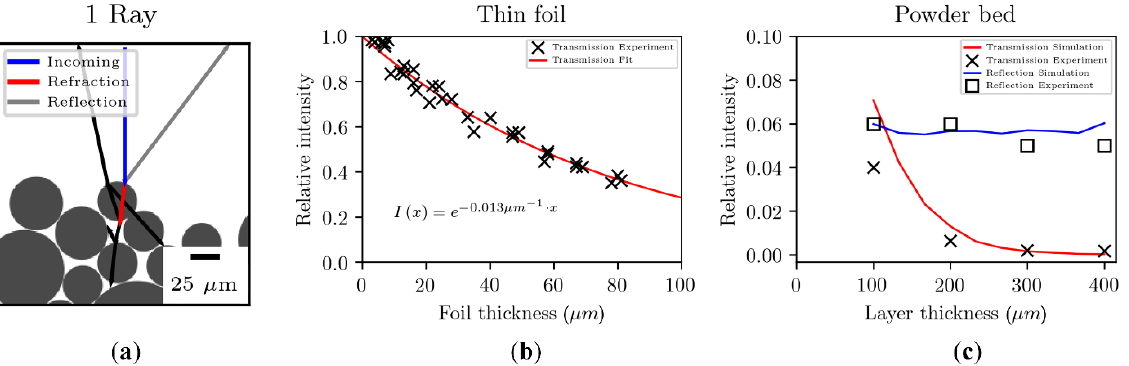
Figure 6. ( a ) Ray-tracing model describing the propagation of a photon through the powder bed; ( b ) relative transmission in PA12 thin foils as function of thickness; ( c ) comparison between the simulation results and experimental data for the relative transmission and reflection of a PA12 powder bed. Adapted from [79].